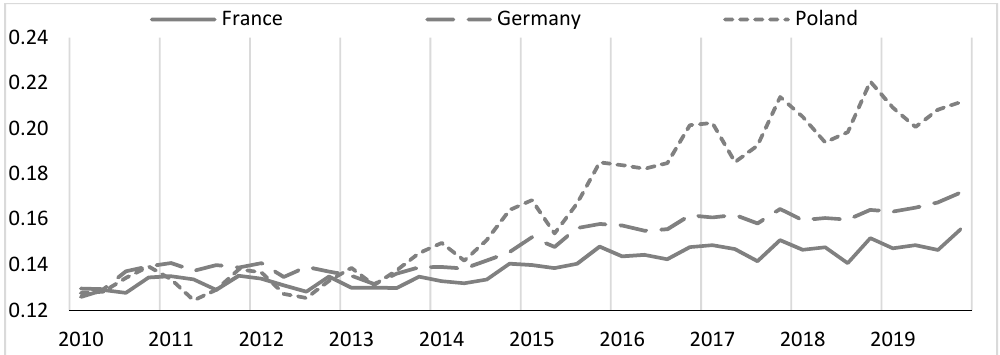
Figure 4. Import intensity of private consumption, own work, source: Eurostat.